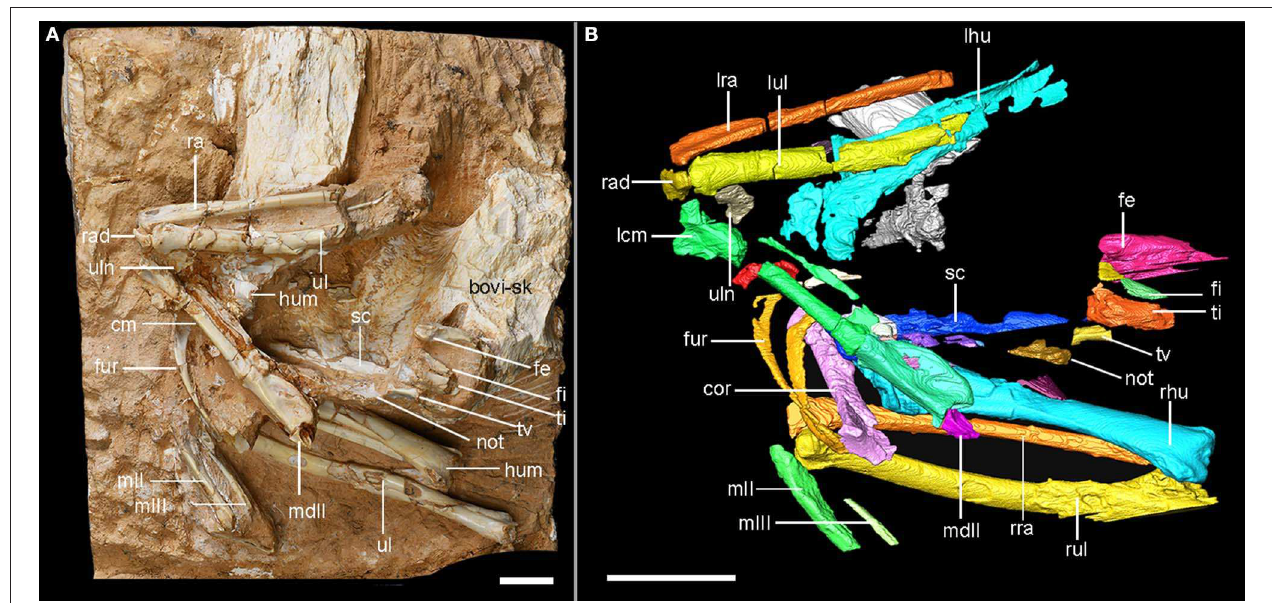
FIGURE 2 | Photograph and colorized CT reconstruction of the major bones for the holotype of Linxiavis inaquosus (IVPP V24116). Anatomical abbreviations: bovi-sk–bovid skull, cor–coracoid, cm–carpometacarpus, fe–femur, fi–fibula, fur–furcula, hum–humerus, lcm–left carpometacarpus, lhu–left humerus, lra–left radius, lul–left ulna, mII–metacarpal II, mIII–metacarpal III, mdII–manual digit III phalanx 2, not–notarium, ra–radius, rad–radialae, rhu–right humerus, rra–right radius, rul–right ulna, sc–scapula, ti–tibia, tv–thoracic vertebrate centrum, ul–ulna, uln–ulnare. Scale bar equals